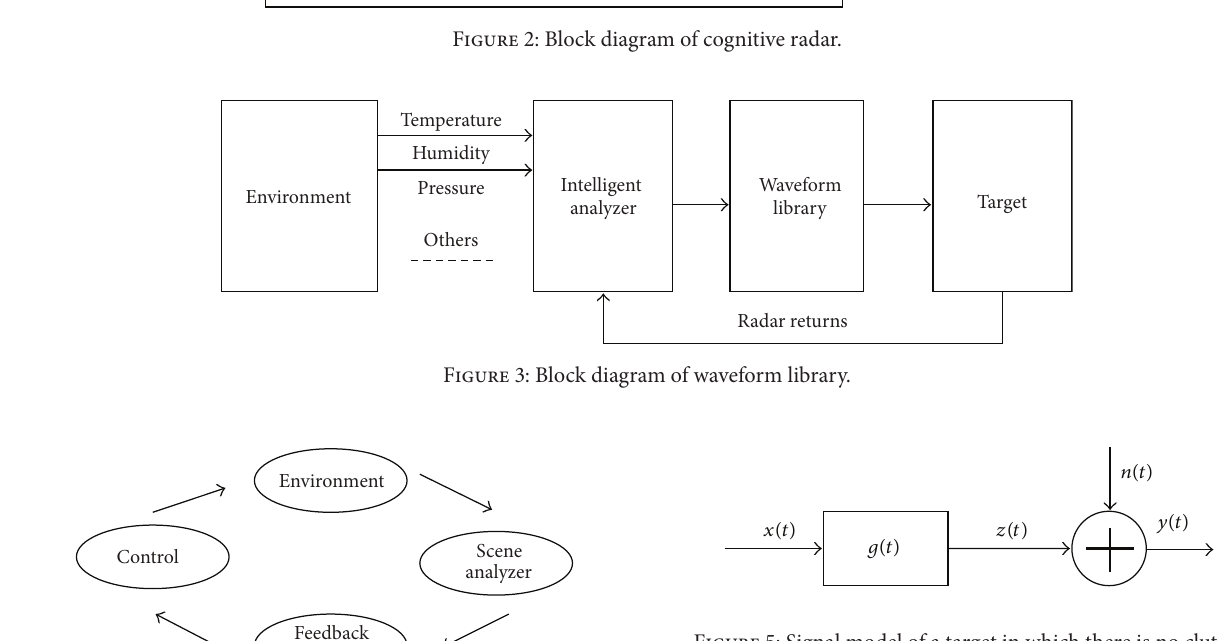
Figure 5: Signal model of a target in which there is no